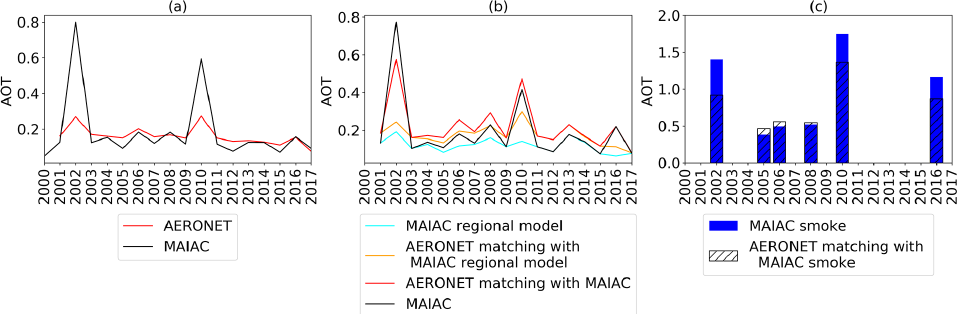
Figure 4. The year-to-year variations of AOT at 0.55µm (May–September, mean values) according to AERONET (Moscow_MSU_MO) and MAIAC data: (a) all available AERONET and MAIAC data, (b) matching AERONET and MAIAC data for all cases and for the regional aerosol model only, and (c) AOT MAIAC in cases of smoke detection and matching AERONET